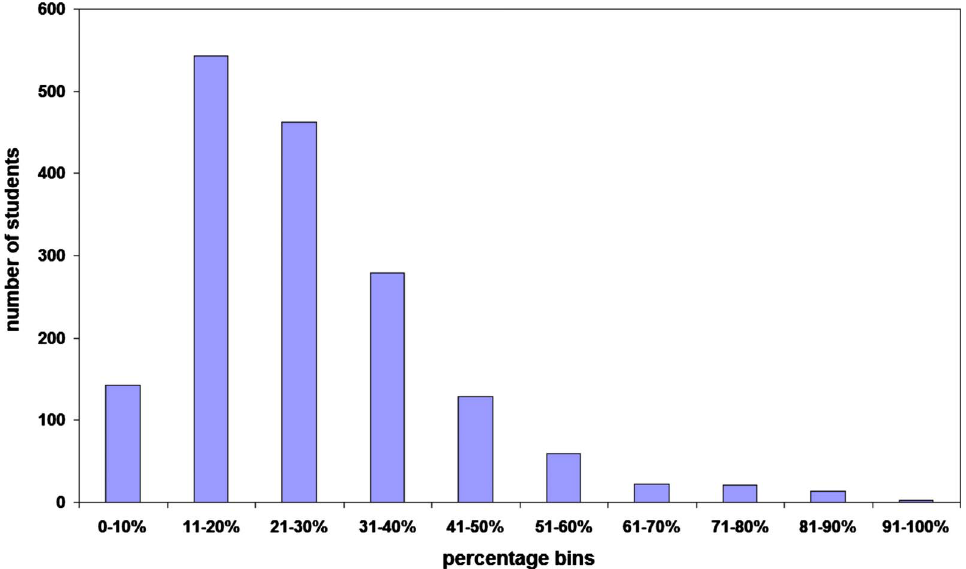
FIG. 1. (cid:1) Color (cid:2) Distribution of test scores for gymnasium